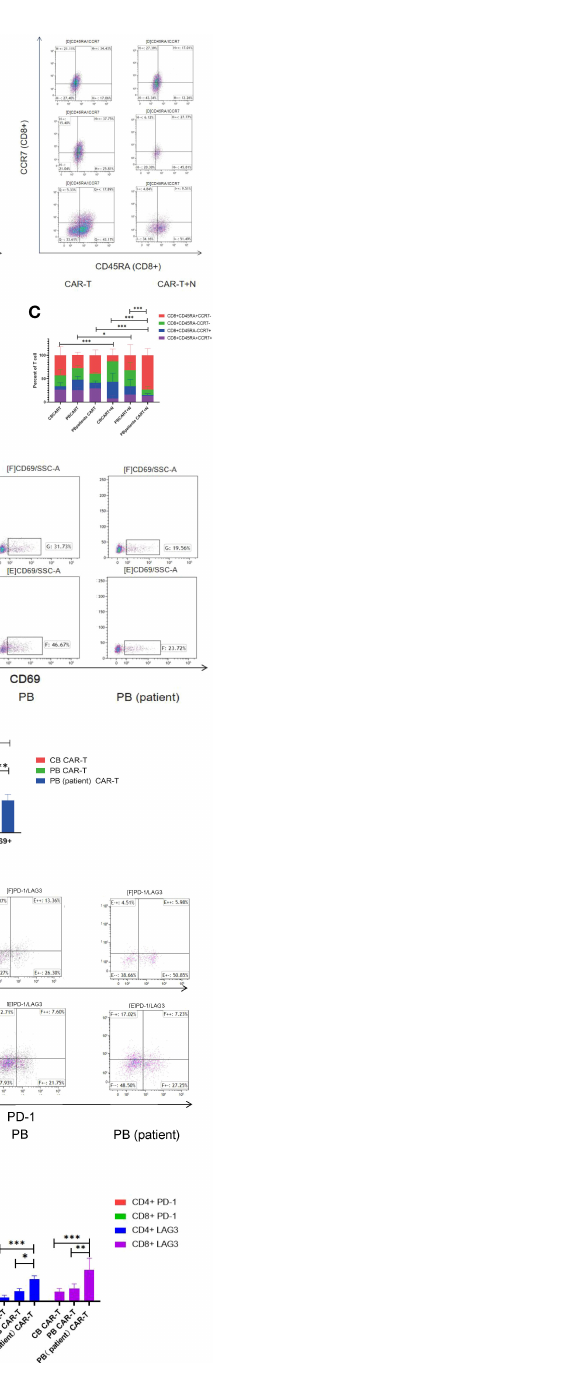
FIGURE 3 Changes in T-cell subsets, activation, PD-1, and LAG3 expression of CAR-T cells in the three groups after coculture with Nalm6-GL. (A) Flow cytometry analysis of TN, TCM, TEM, and TEMRA in CAR-T cells of the three groups. Right upper quadrant: naive T(CD45RA+CCR7+), left upper quadrant: TCM(CD45RA-CCR7+), left lower quadrant: TEM(CD45RA-CCR7-), and right lower quadrant: TEMRA(CD45RA+CCR7-). (B, C) Proportion of TN, TCM, TEM, and TEMRA in CAR-T cells. (B) CD4+T cells, (C) CD8+T cells, red represents TEMRA, green represents TEM, blue represents TCM, and purple represents naive T cells. (D) Flow cytometry analysis of CD69 in the three groups of CAR-T cells after coculture with Nalm6-GL for 18 h (E) Expression of CD69 in the three groups of CAR-T cells after coculture with Nalm6-GL for 18 h (F) Flow cytometry analysis of the expression of PD-1 and LAG3 in the three groups of CAR-T cells after coculture with Nalm6-GL for 72 h (G) The expression of PD-1 and LAG3 in the three groups of CAR-T cells after coculture with Nalm6-GL for 72 h. PD-1, programmed death 1; LAG3, Lymphocyte- activation gene 3; TN, Naive T cell; TCM, Central memory T cell; TEM, effector memory T cell; TEMRA, Terminal effector T cell; Treg, regulatory T cell. *p < 0.05, **p < 0.01, ***p <